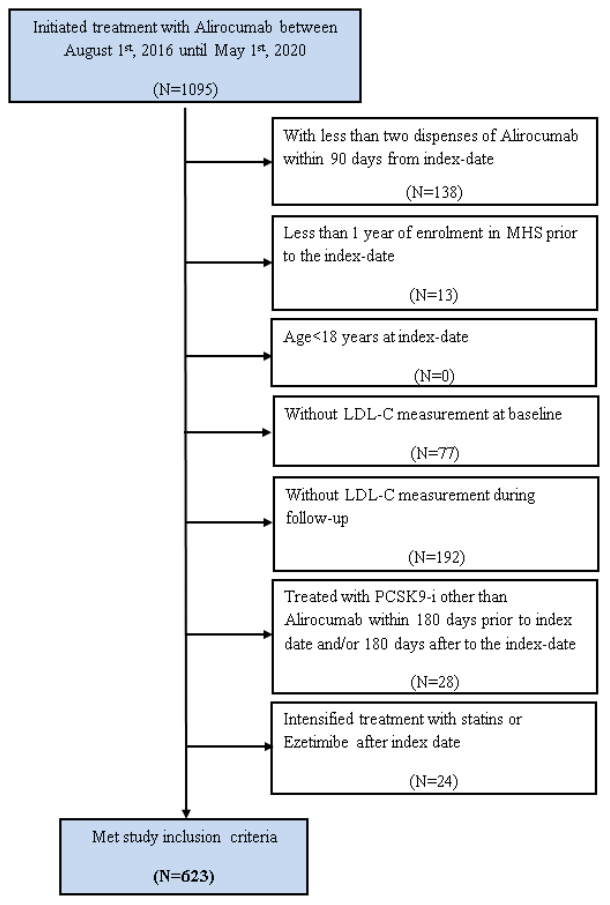
Figure 1. Patient flow diagram. Abbreviations: BMI: Body mass index; LDL: Low-Density Lipopro-